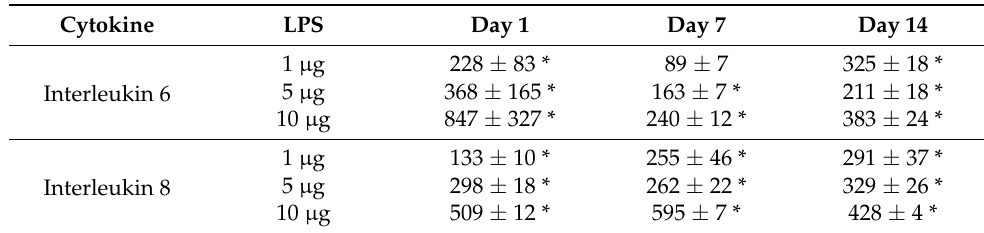
Table 2. Time-dependent changes (%) of cytokine secretion by EpiAirway™ tissues upon stimulation to 1, 5 and 10 µ g lipopolysaccharide (LPS). Secretion of unstimulated tissues is set as 100%. Significant differences ( p < 0.05) between treated and untreated samples are indicated by an asterisk. Cytokine